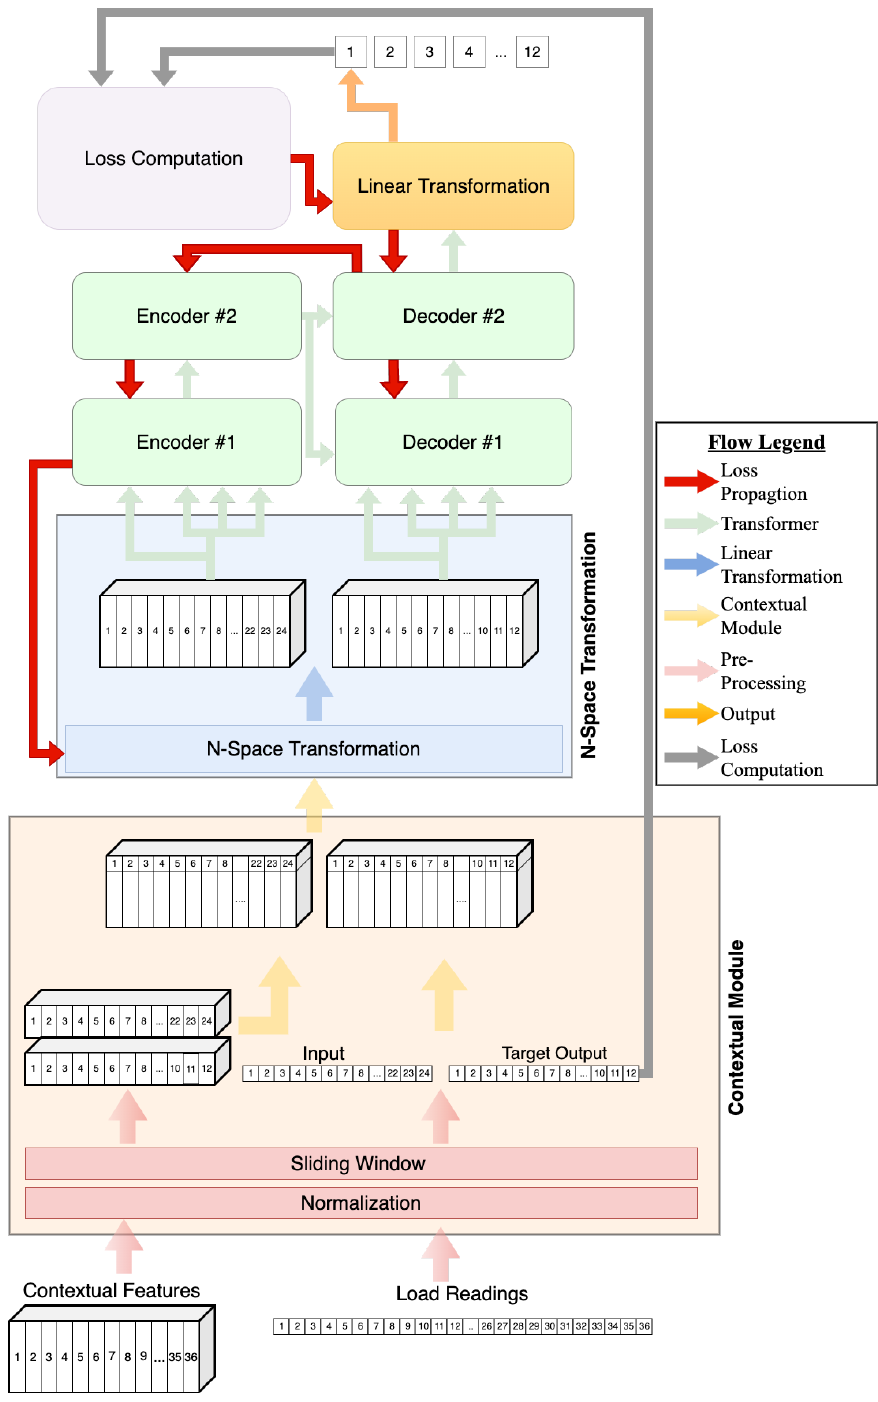
Figure 1. Training